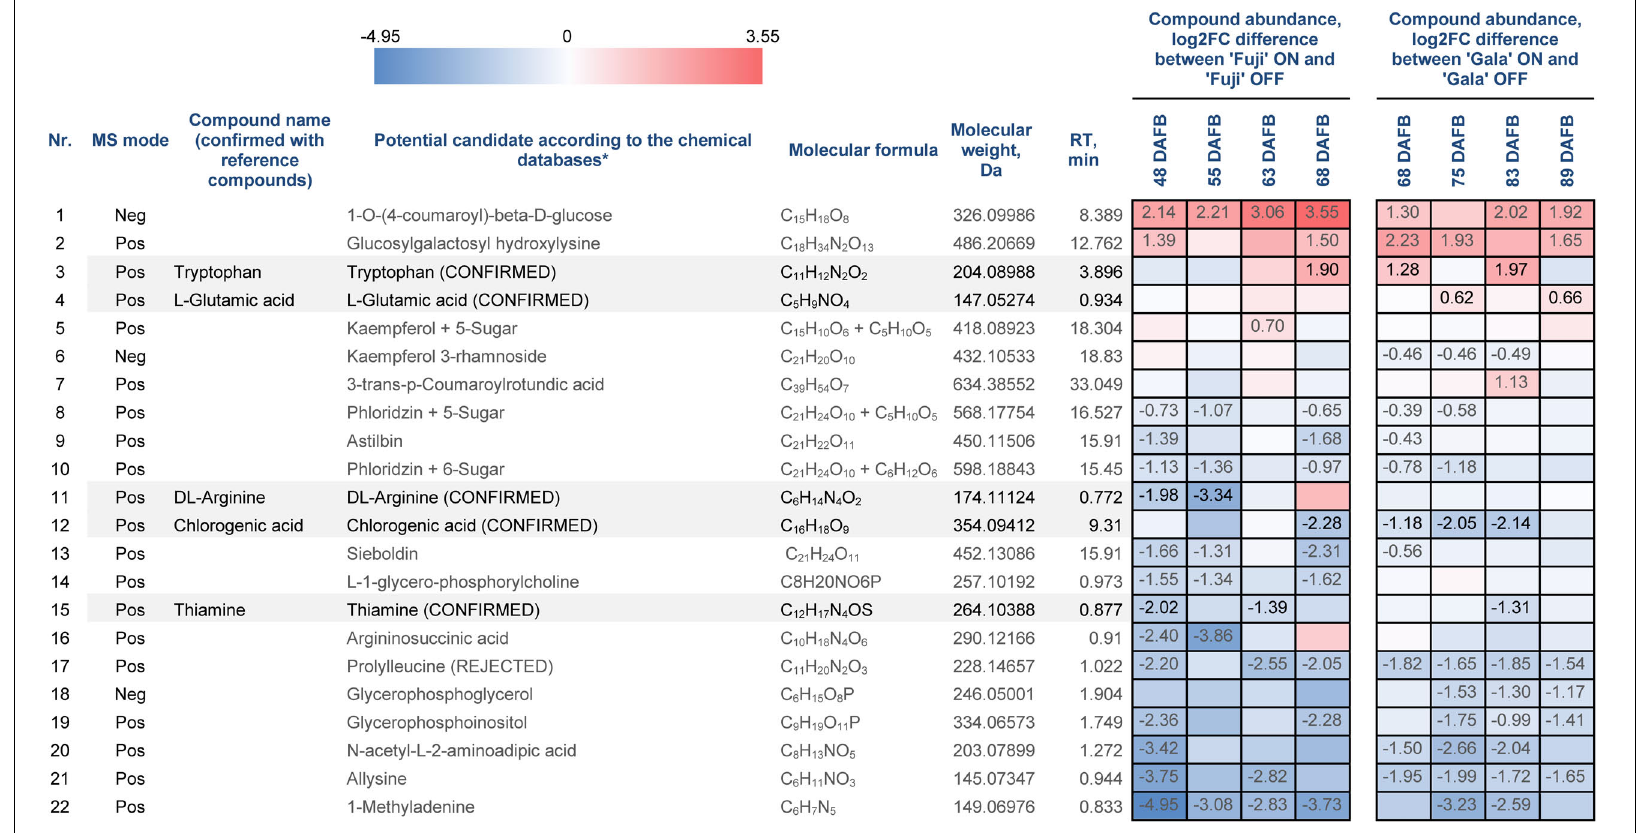
FIGURE 6 | Differentially abundant metabolites (DAMs) in spur buds from ON- and OFF-trees of ‘Fuji’ and ‘Gala’. *Pre-identified metabolites according to mzCloud, ChemSpider, Plant Metabolic Network (PMN), and PubChem. “CONFIRMED” indicates identified organic molecules confirmed with reference compounds, “REJECTED” indicates structure and/or retention time is not confirmed using reference compounds. Negative log2FC values (blue) indicate a higher compound abundance in OFF, positive log2FC values (red) indicate a higher compound abundance in ON. Cells of the same color on the heat map indicate the same level of log2FC metabolite abundance difference between ON- and OFF-trees and do not indicate significant differences. Numbers on the heat map specify exact log2FC differences between ON- and OFF-trees and mark significant differences at multiple adjusted p ≤